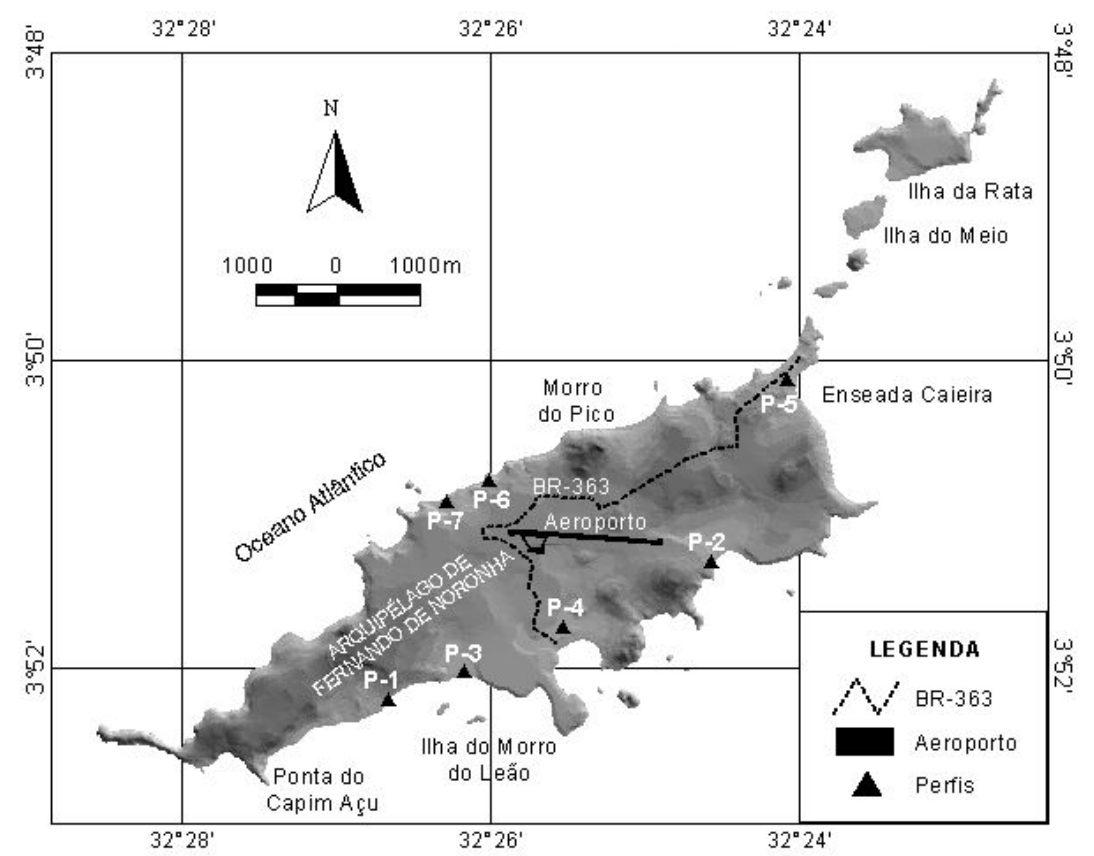
Figura 1. Mapa do Arquipélago de Fernando de Noronha (PE), com a localização dos perfis de